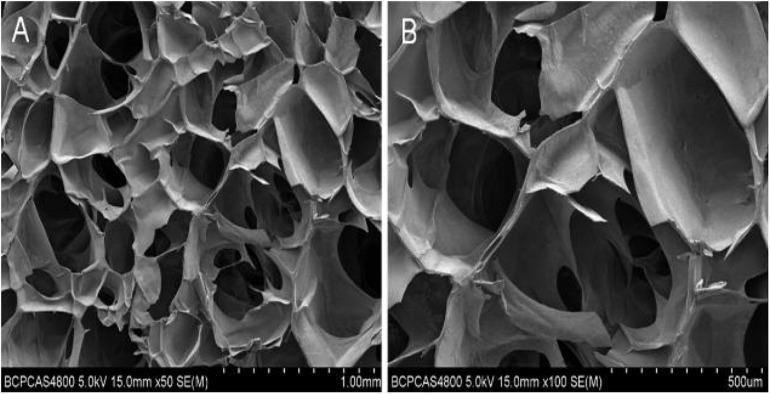
Electron microscopic view of hydrogel. (A) Electron microscopic view of hydrogel with low magnification. (B) Electron microscopic view of hydrogel with high magnification.